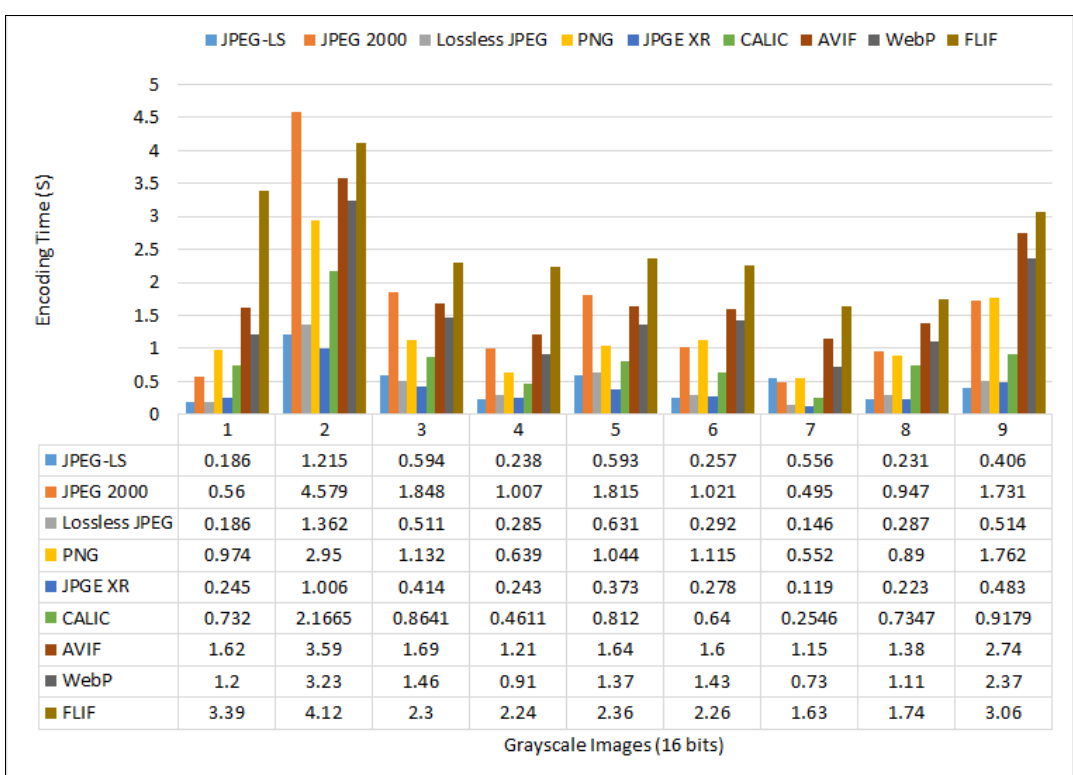
Figure 21. Comparison of encoding times for 16-bit greyscale